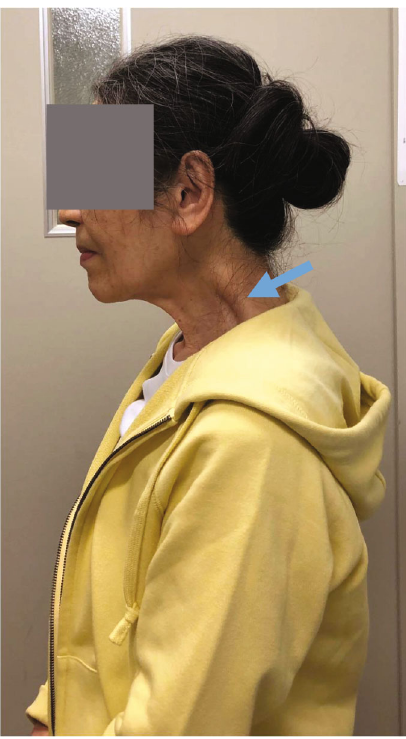
Figure 7: Lateral view of the patient ’ s neck at the 3rd AR-PT. DHS was improved. The bulged muscles were still seen at this point